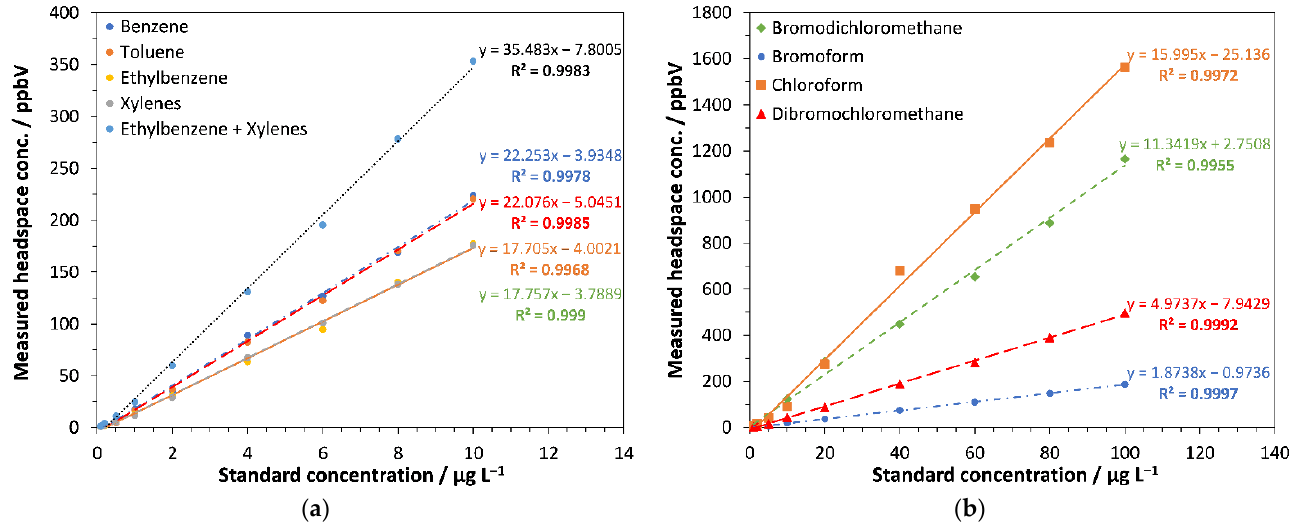
Figure 2. Linearity of headspace measurements versus standard concentration averaged across product ions for each compound, showing the linear fit and its regression coefficient, R 2 . ( a ) BTEX; ( b ) THMs. ( b )